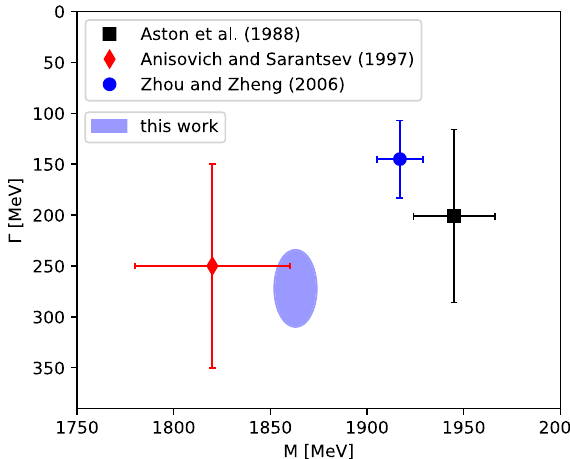
Fig. 10 Extracted pole position of the K ∗ works of Aston et al. [63], Anisovich and Sarantsev [93], and Zhou and Zheng [94]